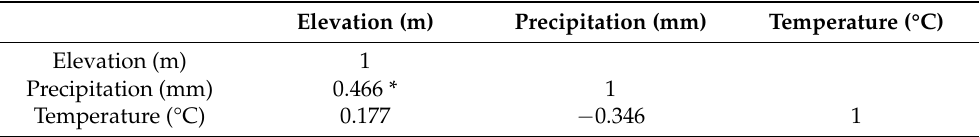
Table 3. The correlation coefficients between the sampling points of Zygophyllaceae plants in arid and semi-arid areas of